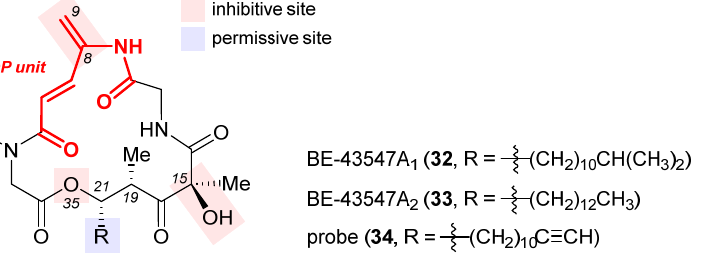
Figure 8. Structures of BE-43547A 1 ( 32 ), BE-43547A 2 ( 33 ), and the clickable probe 34 . The SAR illustrated in their structures consists of inhibitive (red) and permissive (blue) sites: the former must be reserved for high activity, whereas the latter can tolerate moderate change.